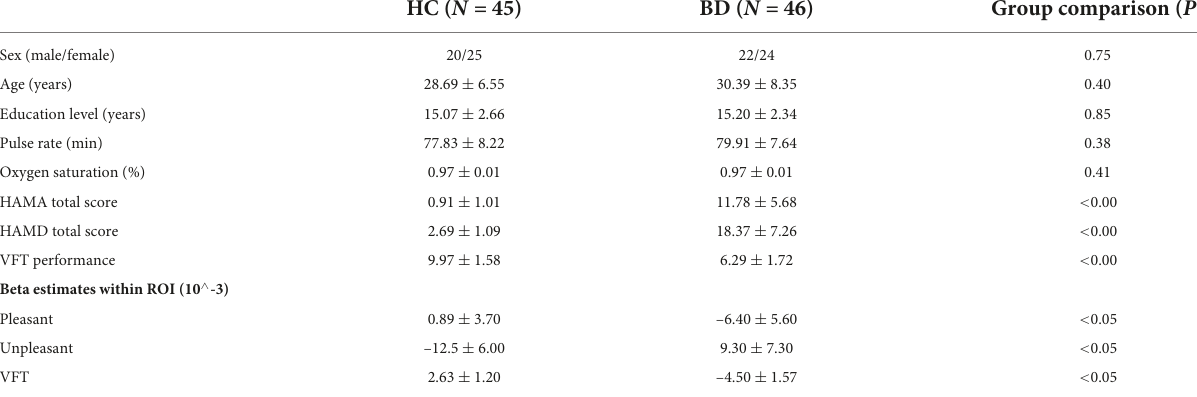
TABLE 1 Demographic characteristics, clinical information, and VFT performance, beta estimates within region of interest (ROI) during